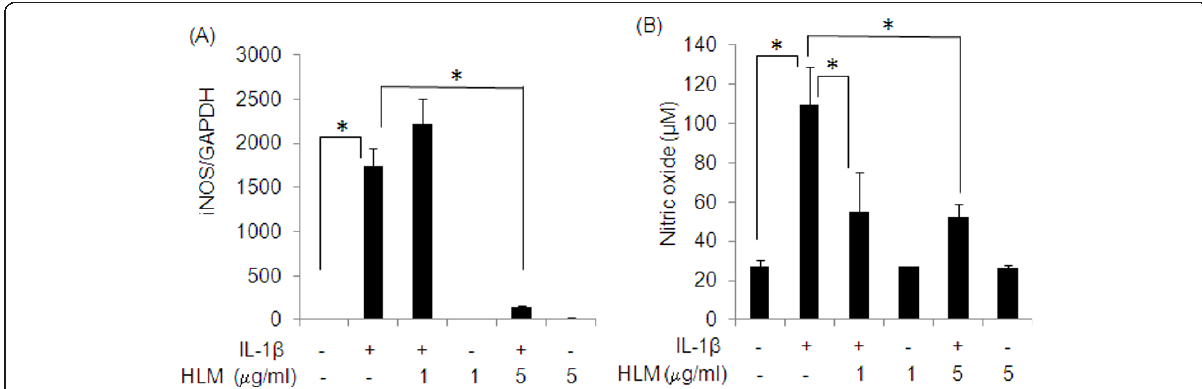
Figure 2 Effect of HLM ( Uncaria tomentosa ., Boswellia spp ., Lepidium meyenii and L-Leucine ) on the IL-1 b -induced gene expression of inducible nitric oxide synthase (iNOS) (A) and on the production of nitric oxide (NO) (B) in human OA chondrocytes . Chondrocytes were pretreated for 2 h with HLM (1-5 μ g/ml) and then stimulated or not stimulated with IL-1 b (5 ng/ml) for 24 h. Relative gene expression of iNOS was determined by Real-time PCR using GAPDH as endogenous control and compared with un-stimulated control. Corresponding culture supernatants were analyzed for total NO levels. Values represent Mean ± SE of three different experiments run in duplicate. * p < 0.05.